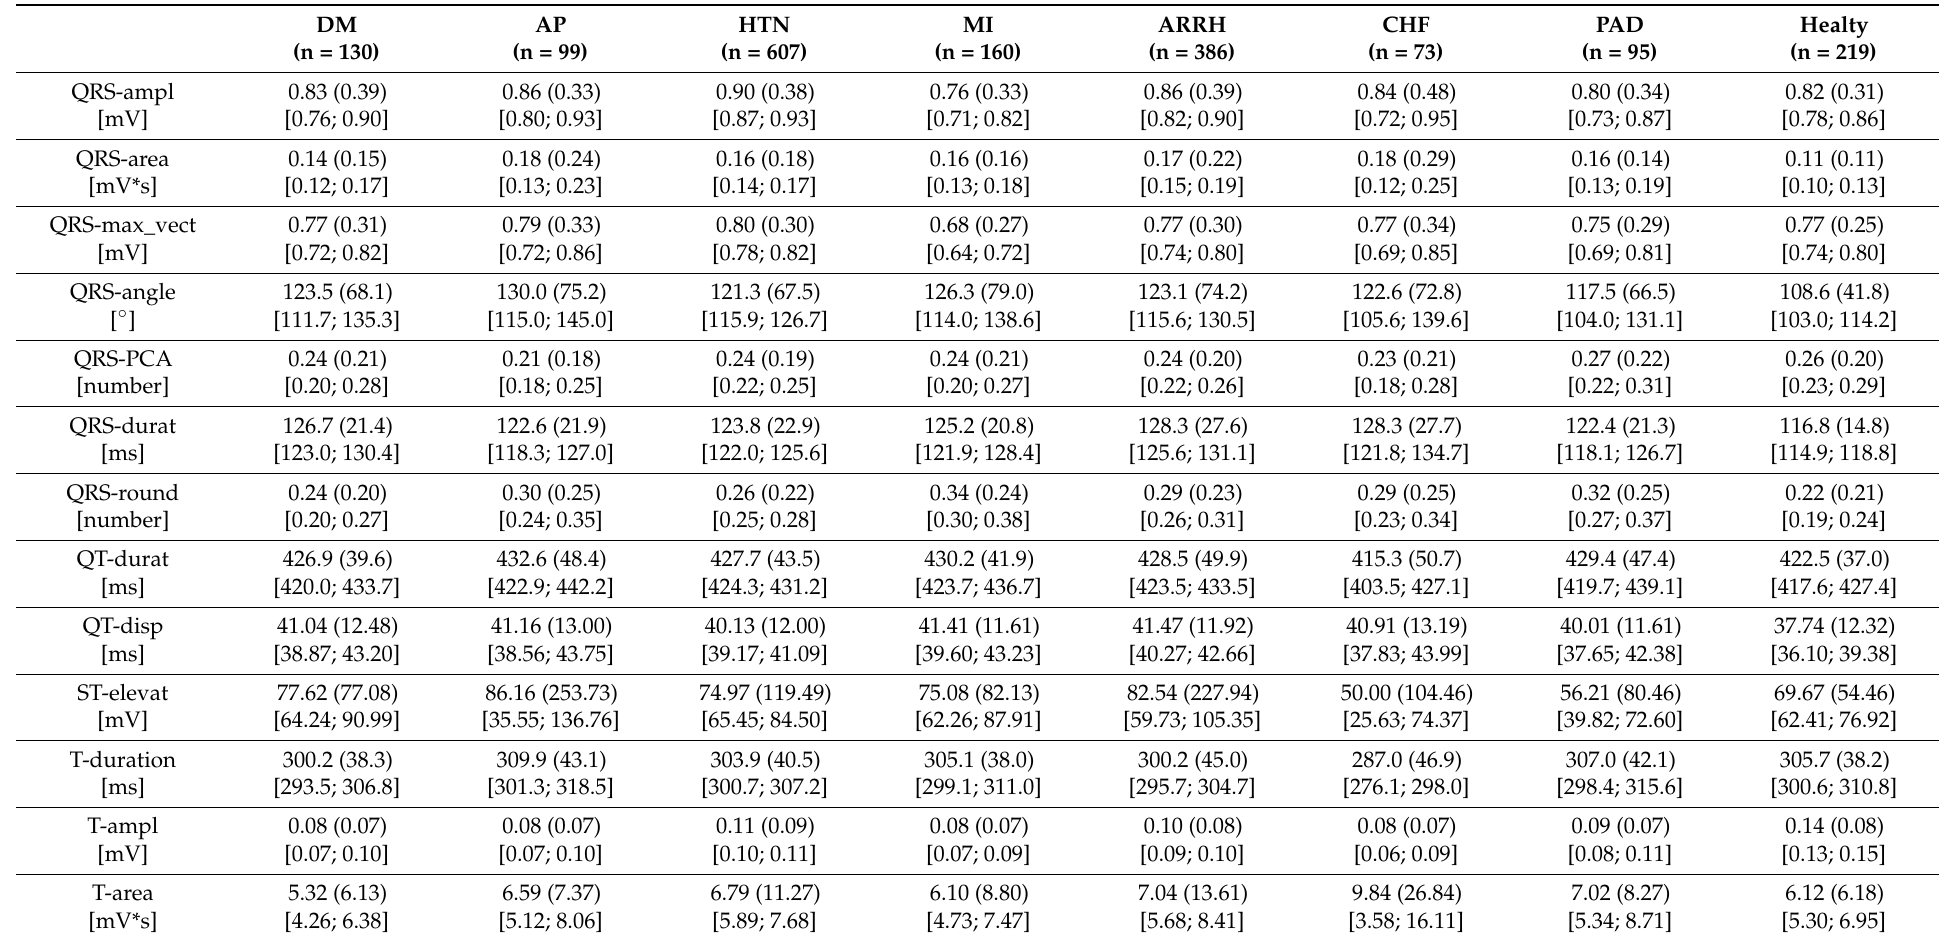
Table 2. Mean values (standard deviation) and 95% confidence interval of the 21 electrocardiographic and vectorcardiographic features, with the corresponding units, in males for cardiovascular diseases and diabetes mellitus and healthy control